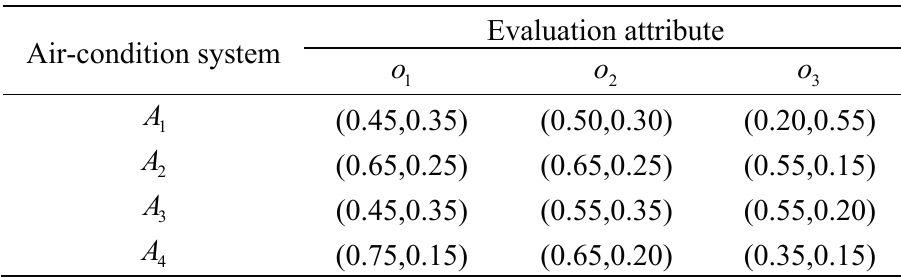
Table 3. Intuitionistic fuzzy decision